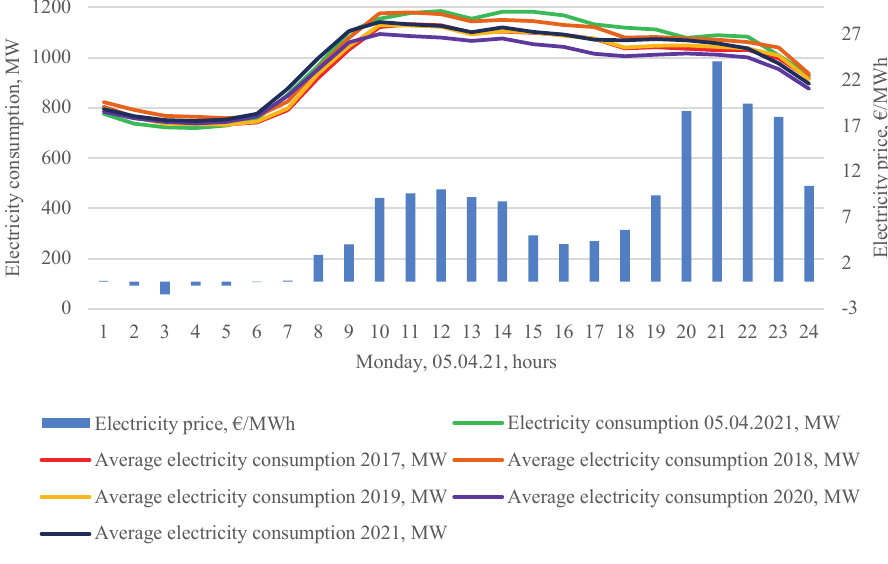
Fig. 8. The comparison of low – cost electricity